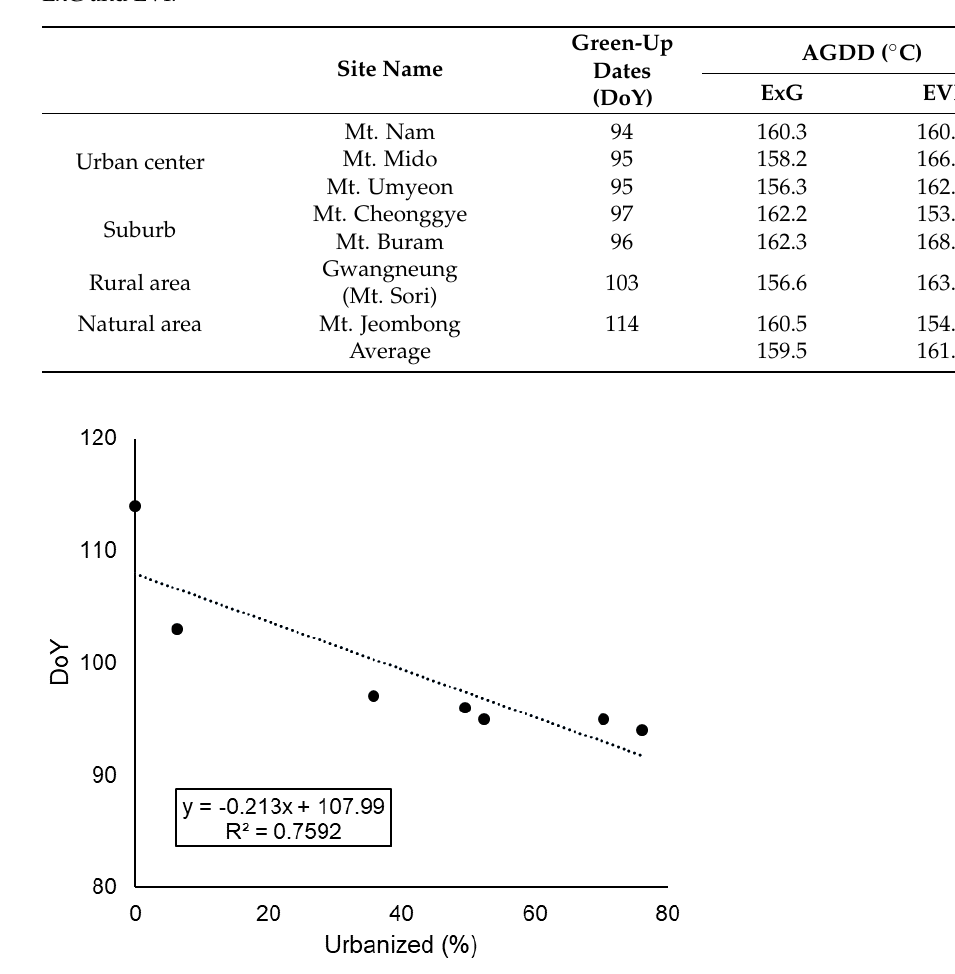
Figure 6. Relationship between dates when AGDD reached 159 °C and urbanization ratio ( p < 0.05).